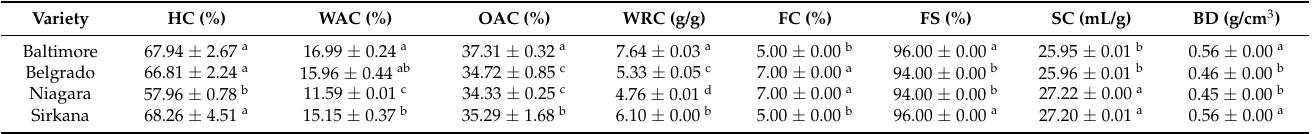
Table 2. Functional properties of carrot pomace powders.